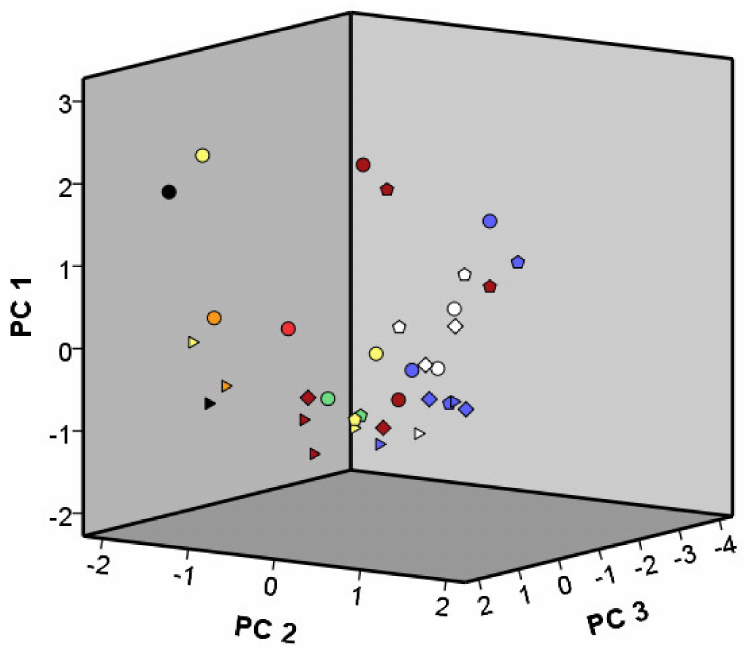
Figure 8. Principal component analysis (PCA) of the normalized peak areas of the volatile organic compounds present in the crumbs of wheat breads made with starter culture-initiated sourdoughs. The starter cultures are indicated with colored symbols: Acetobacter pasteurianus IMDO 386B, orange; Limosilactobacillus fermentum IMDO 222, blue; Gluconobacter oxydans IMDO A845 (aerated through the flour–water mixture (GO1 and GO2), dark red; aerated through the fermenter headspace (GO3), red); Lentilactobacillus hilgardii IMDO 2M0G15, yellow; Liquorilactobacillus nagelii IMDO 2M48G6, green; Latilactobacillus sakei CTC 494, white; Staphylococcus carnosus IMDO F4P1, black. The symbol shapes indicate the fermentation time of the sourdough productions: triangles, 0 h; diamonds, 24 h; pentagons, 48 h; and circles, 72 h. Table 3. Volatile organic compounds identified through SMPE-GC-MS in the crumbs of wheat breads made with starter culture-initiated sourdoughs according to the three principal components (PC) obtained after principle component analysis of all